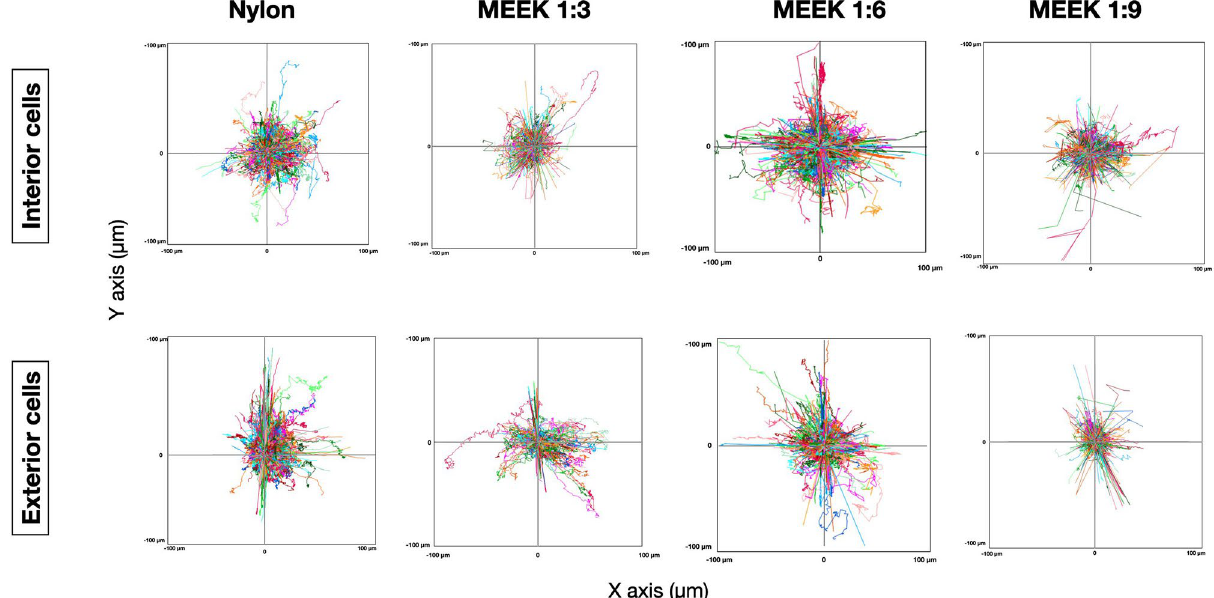
Figure 7. Wind-Rose plots depicting the migratory behaviors of fibroblast cells on various materials. The fibroblast cells on nylon dressing and MEEK gauzes at 1:3, 1:6 and 1:9 expansion ratios were stained to track their movement, and the cell trajectory was analyzed in each condition. The trajectory plot represents the cell migration direction and distance at the interior and exterior of both nylon dressing and MEEK gauzes during 0–72 h. Each line indicates an individual path of each